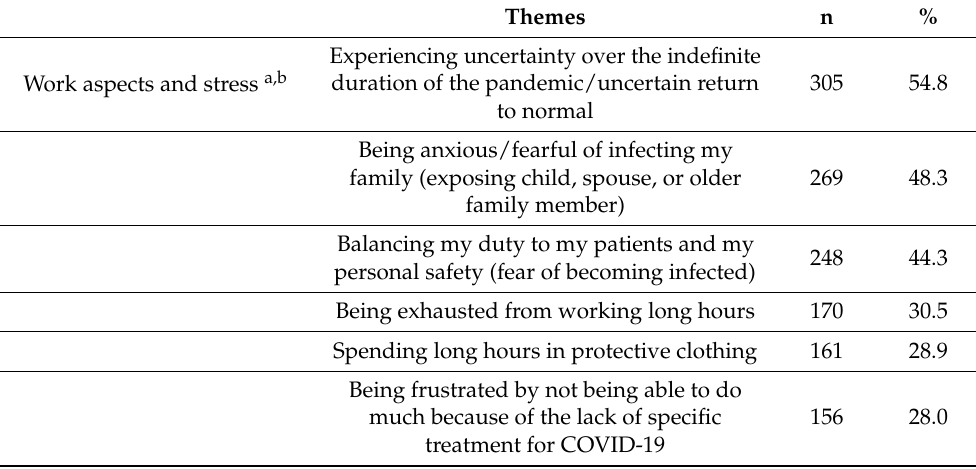
Table 7. Percentage of perceived stressful aspects of treating COVID-19 patients, Sept.–Dec.